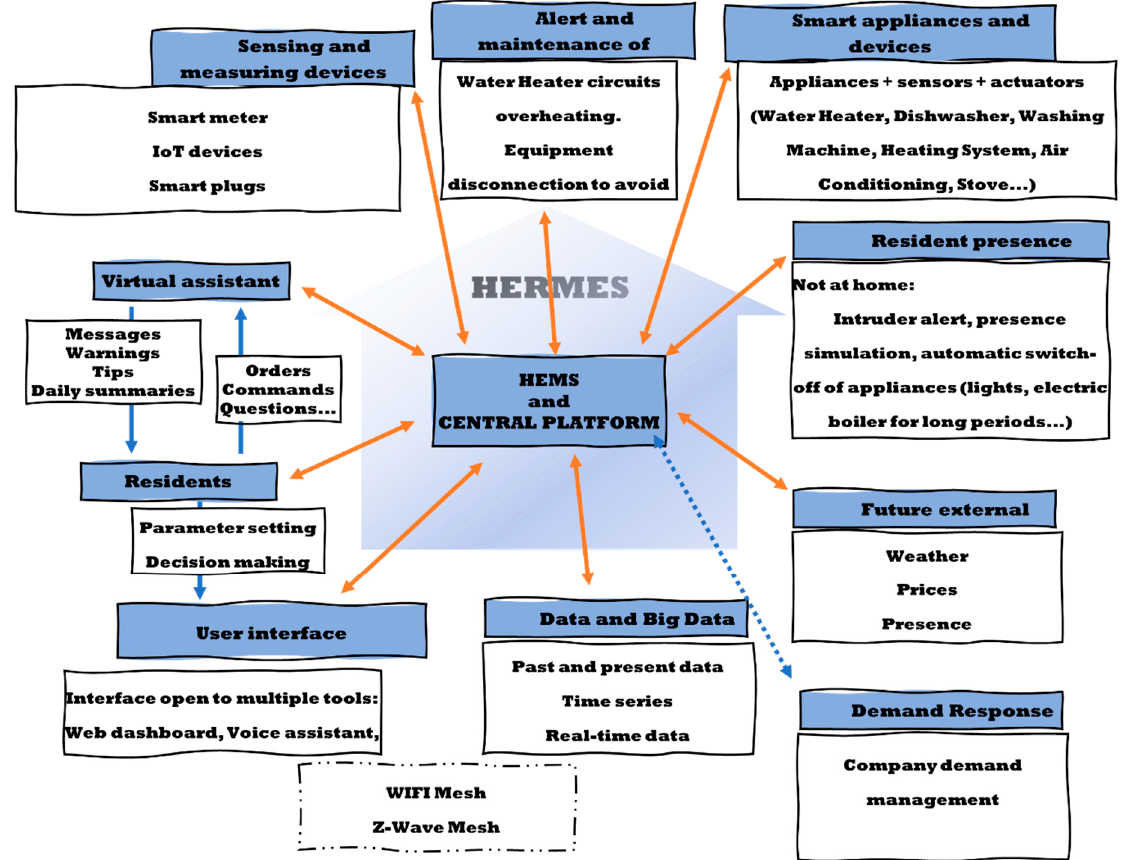
Figure 5. The general framework of HERMES system elements and services.